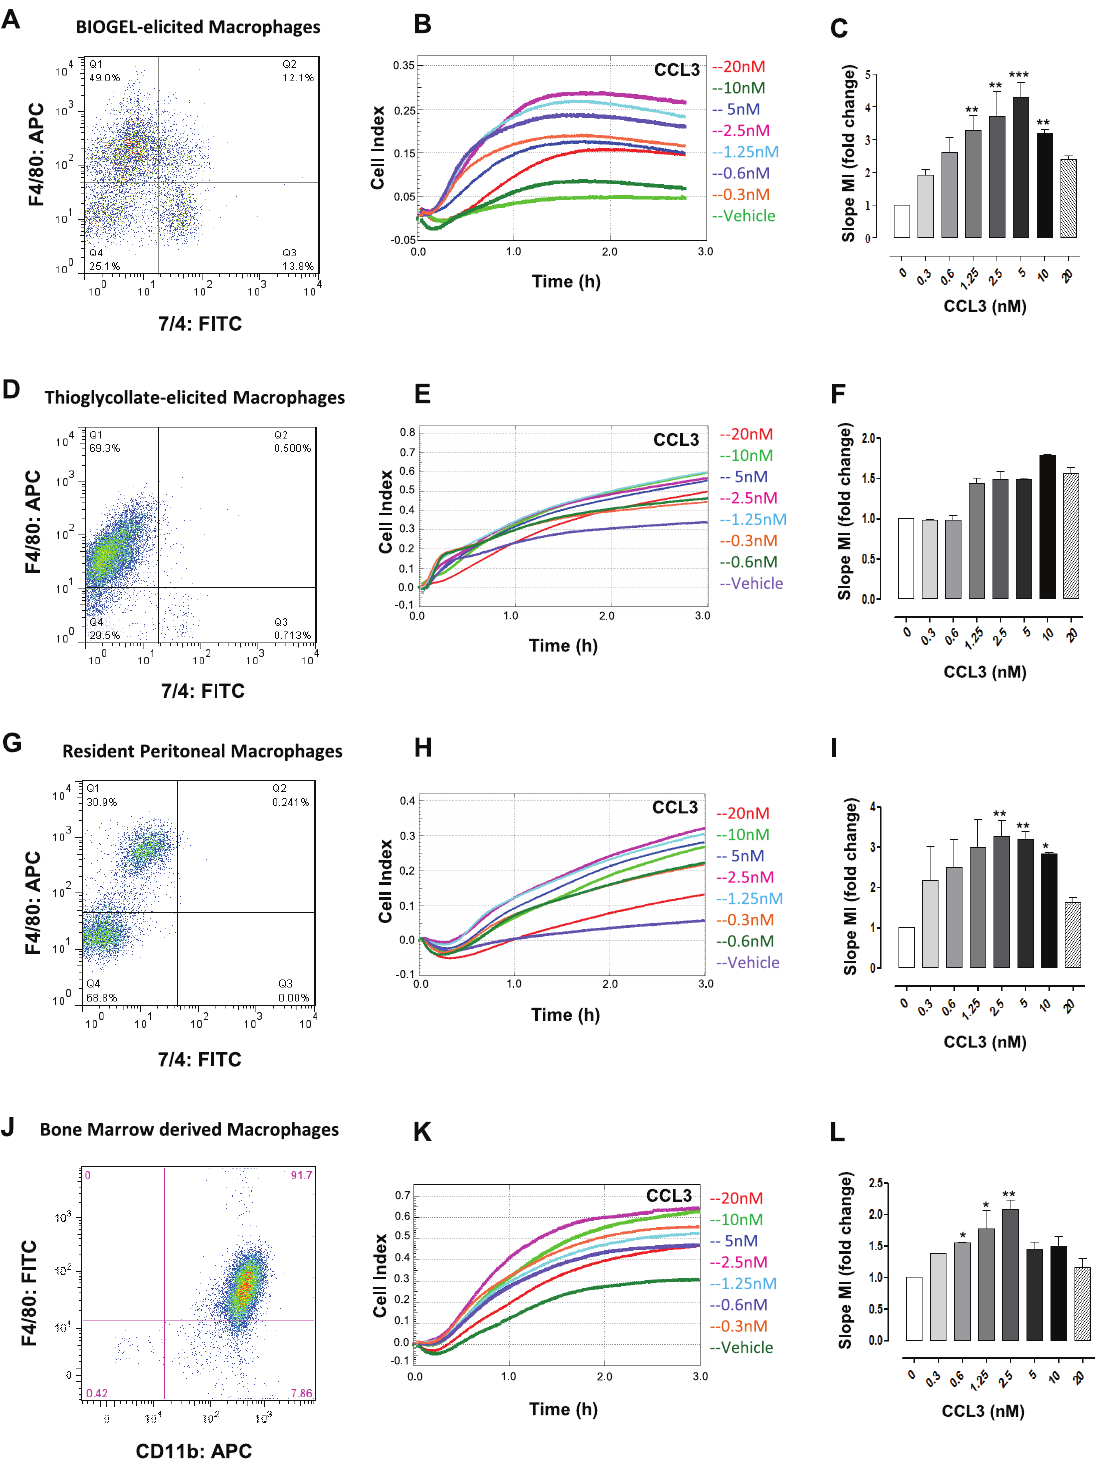
Figure 2. Real-time chemotaxis of different murine macrophage populations to murine CCL3. Panels A, D, G & J are representative FACS plots of the four different murine macrophage populations tested in the RTCA-DP system chemotaxis assay. ( A ) Injection with 2% Bio-Gel (polyacrylamide beads) typically yields 60–70% monocyte/macrophages which are collected after 4 days following the initial injection (assessed by staining with F4/80, 7/4 & CD11b antibodies). ( B ) 4 6 10 5 Bio-Gel elicited peritoneal macrophages were allowed to migrate toward indicated concentrations of murine CCL3 for 3 h. ( C ) Migration was measured for each curve of each concentration using slope (set between 15–60 mins) analysis. ( D ) Injection with 4% Thioglycollate generates 70% F4/80 + 7/4 2 macrophages which were harvested 4 days post injection. ( E ) 4 6 10 5 Thioglycollate-elicited peritoneal macrophages were allowed to migrate toward indicated concentrations of murine CCL3 for 3 h ( G ). ( F ) Migration was measured for each curve of each concentration using slope analysis. ( G ) Lavage of the peritoneal cavity in non-elicited conditions yields , 30%